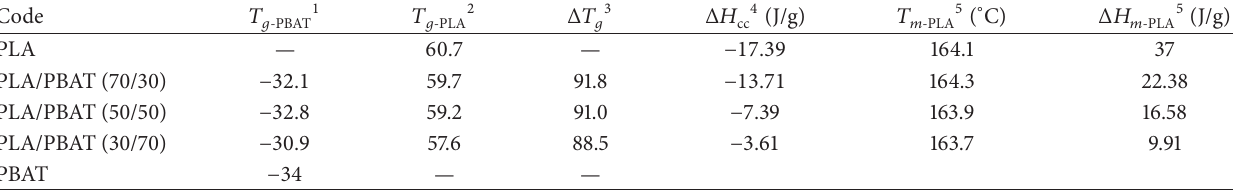
1 𝑇 𝑔 -PBAT : The temperature of glass transition region of PBAT. 2 𝑇 𝑔 -PLA : The temperature of glass transition region of PLA. 3 Δ𝑇